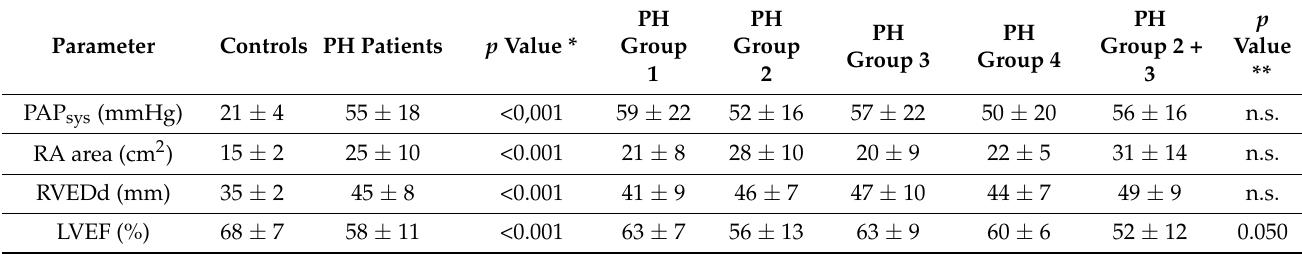
Table 4. Echocardiographic parameters of the study groups in comparison between PH patient subgroups (PH groups) and controls.